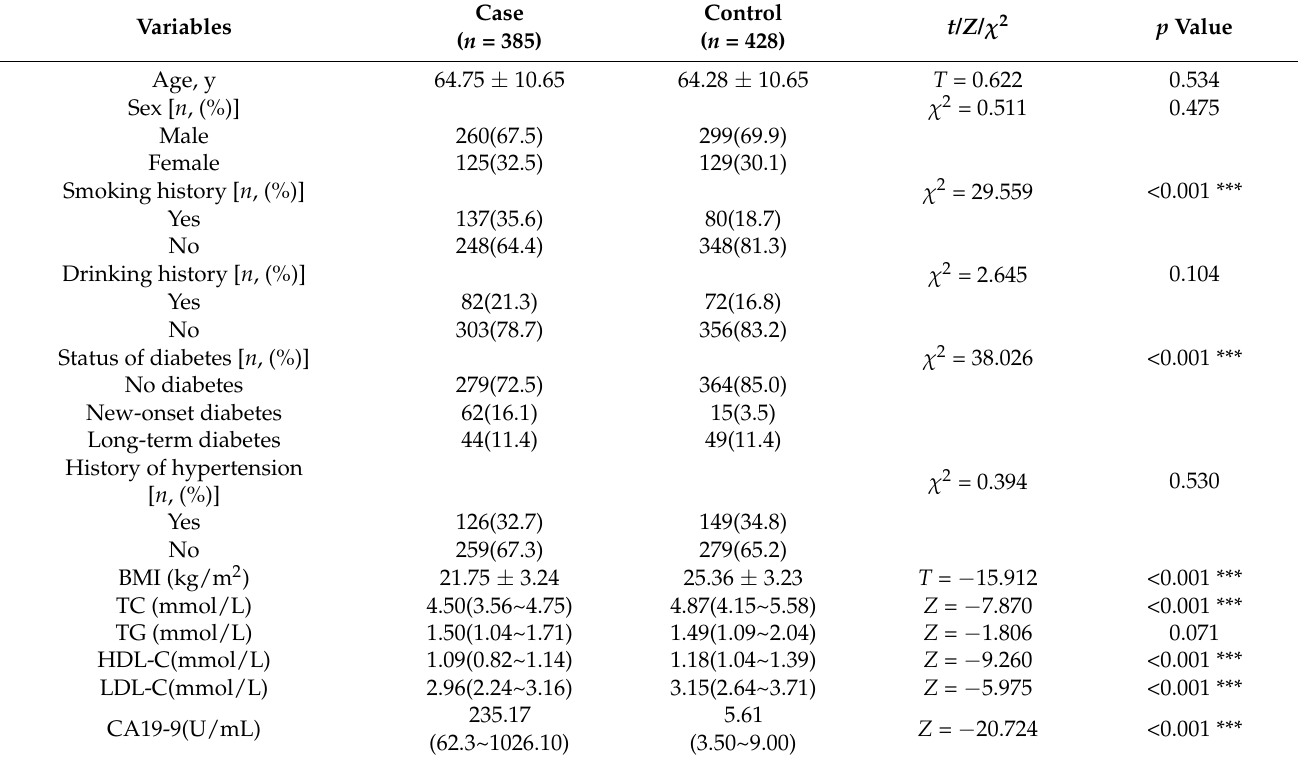
Table 1. Baseline characteristics of the study